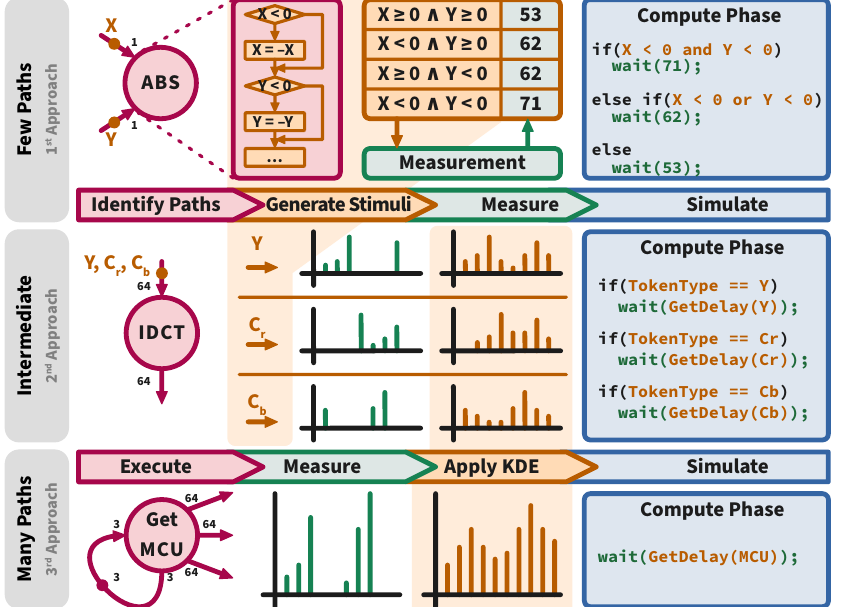
Figure 3. Modeling process with explicit execution path identification shown at Sobel-Filter example actor GetPixel ( top ), using Kernel Density Estimation shown at JPEG-Decoder example actor GetMCU ( bottom ) and a combination of both for actor IDCT ( middle